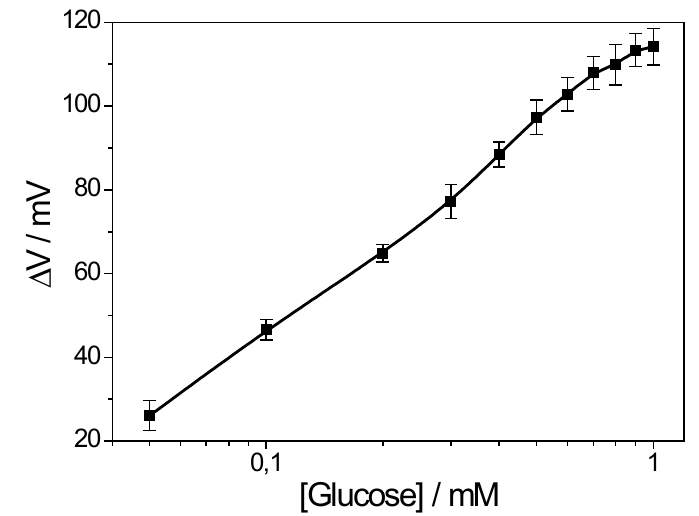
Figure 3. Analytical curve of the PPI/NiTsPc-GOx FET-based biosensor. Measurement conditions: buffer solution 10 mM, pH